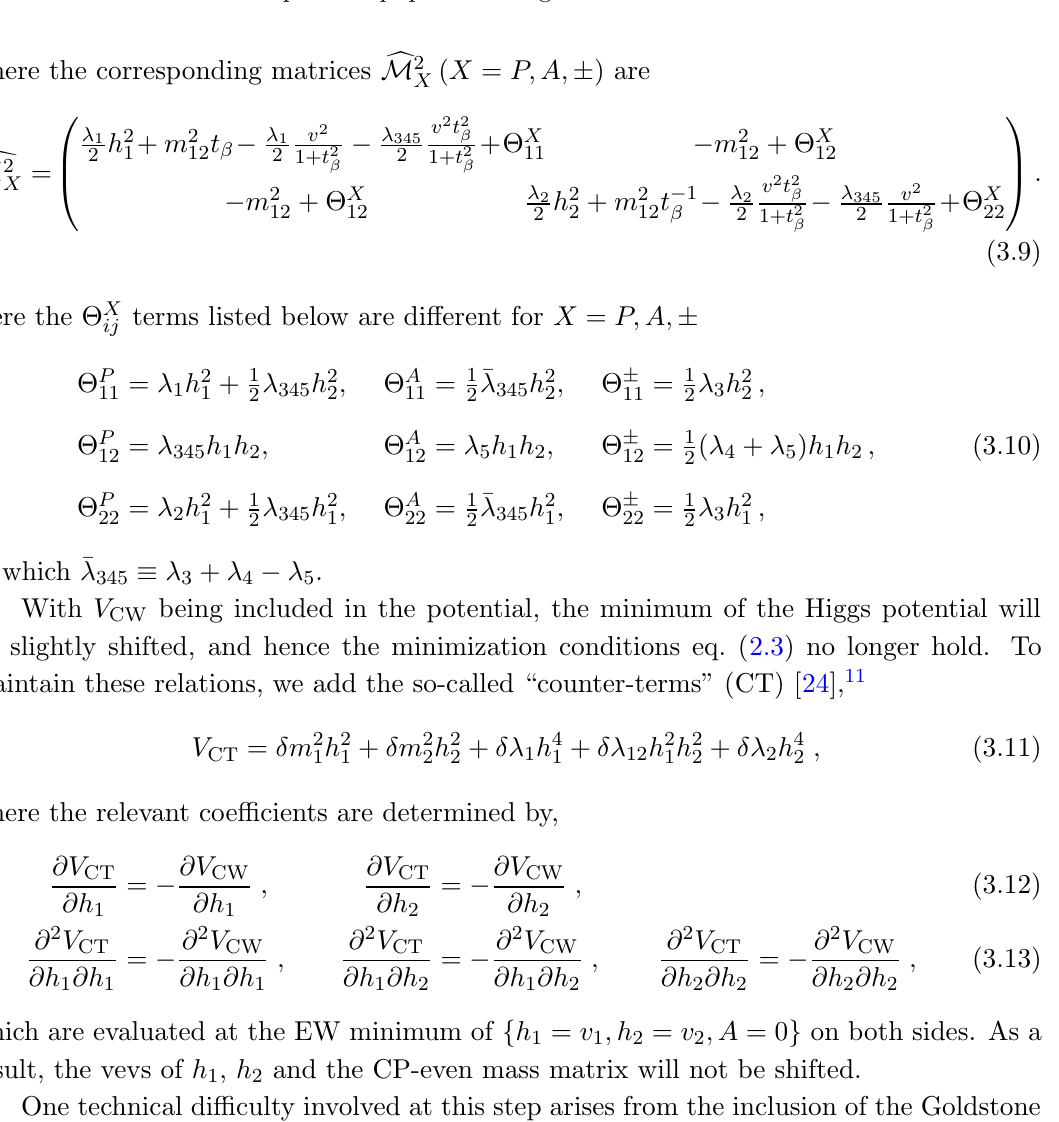
Table 2 . The number of d.o.f. from SM particles of di(cid:11)erent species contributing to the thermal potential. The fermions except the top quark are neglected due to their small